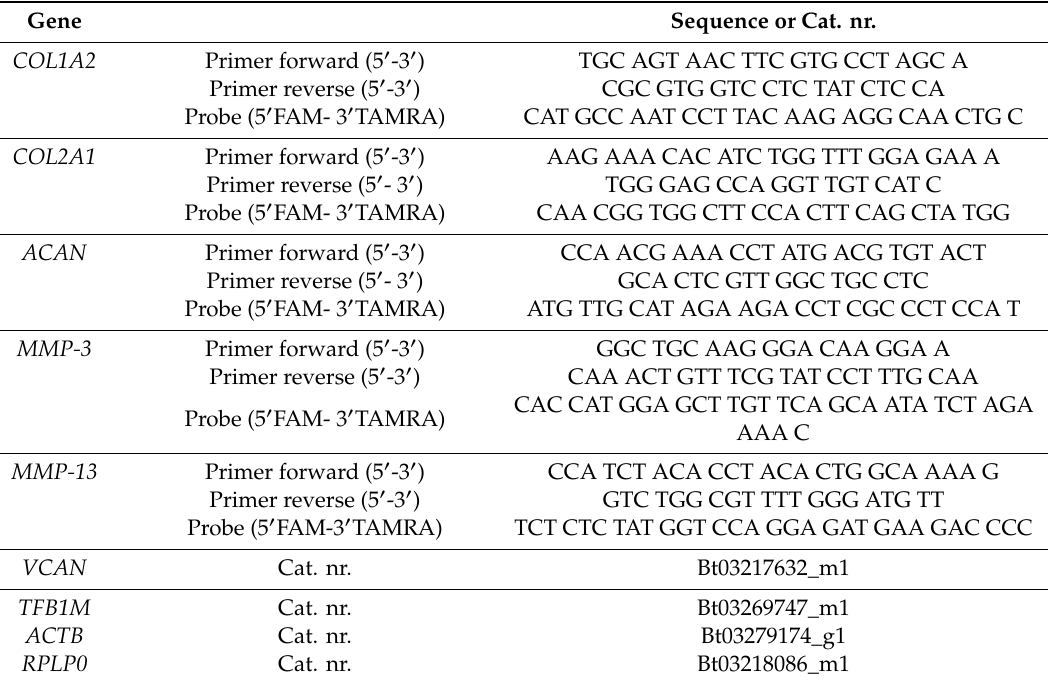
Table 1. Oligonucleotide primers and probes used for qRT-PCR. COL: Collagen; ACAN: Aggrecan; MMP: Matrix metalloproteinase; VCAN: Versican; TFB1M: Beta-1-integrin; ACTB: Beta-actin.